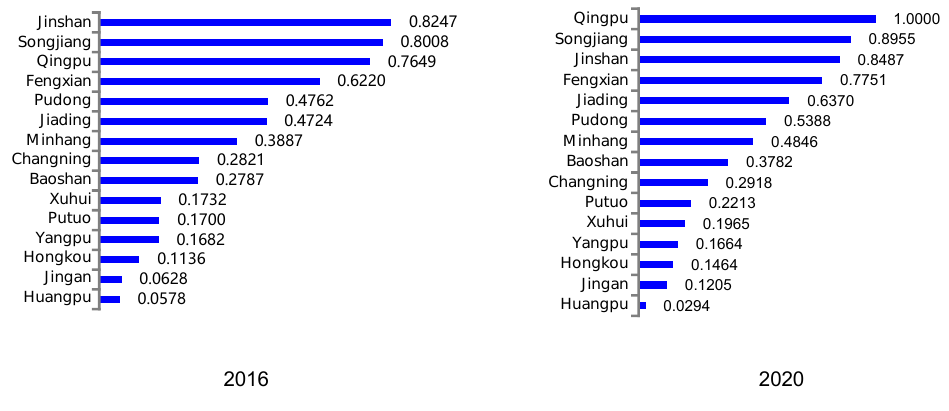
Figure 18. Rankings of each